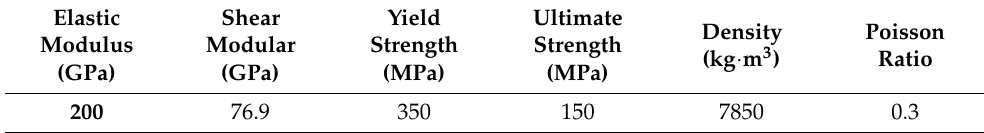
Table 1. Material properties of Q345B.